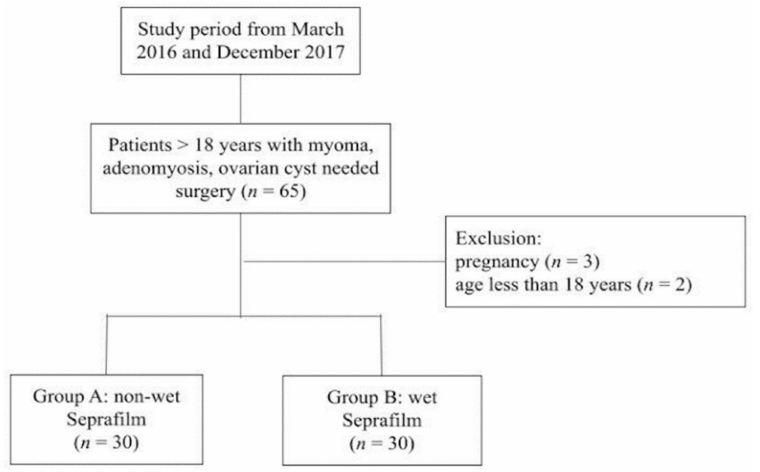
Figure 1. Study flow